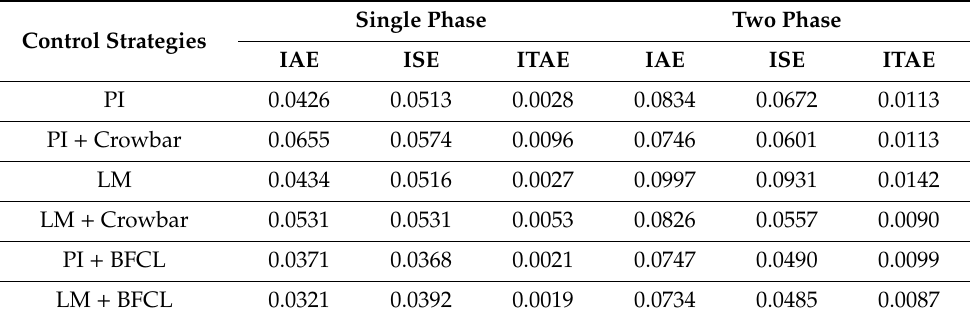
Table 3. Performance index analysis of the designed control scheme for